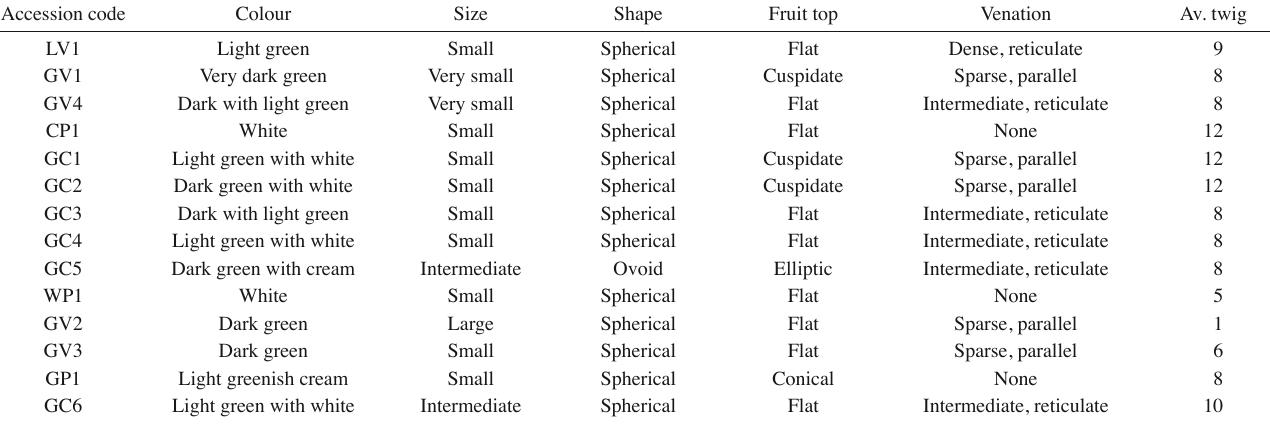
Tab. 2: Morphological characterisation of fruits of fourteen Solanum anguivi Lam. accessions. Accession